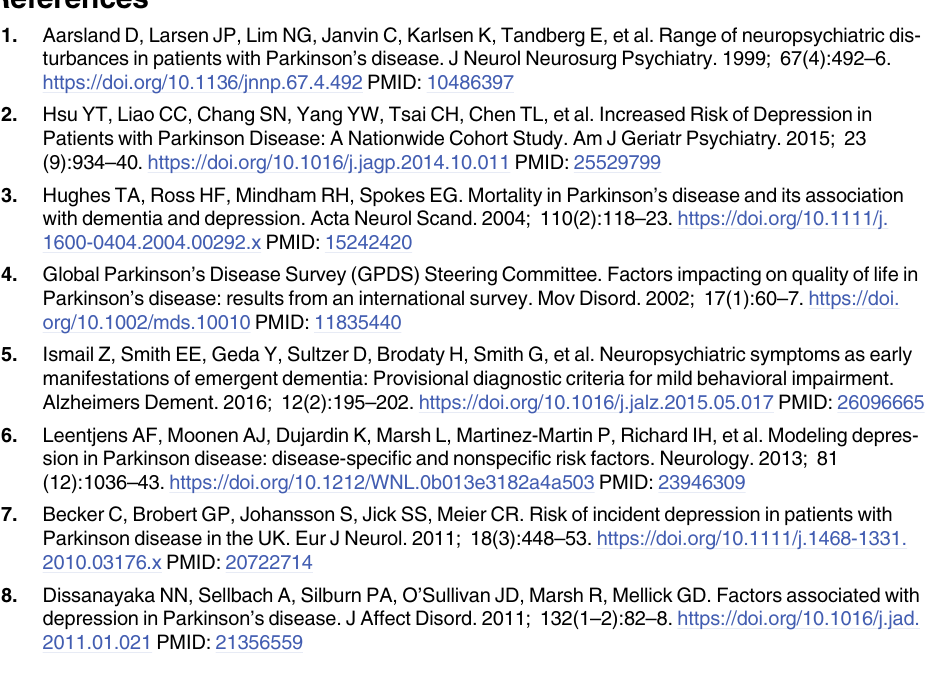
S1 Table. ICD-9-CM codes and ATC codes used in this